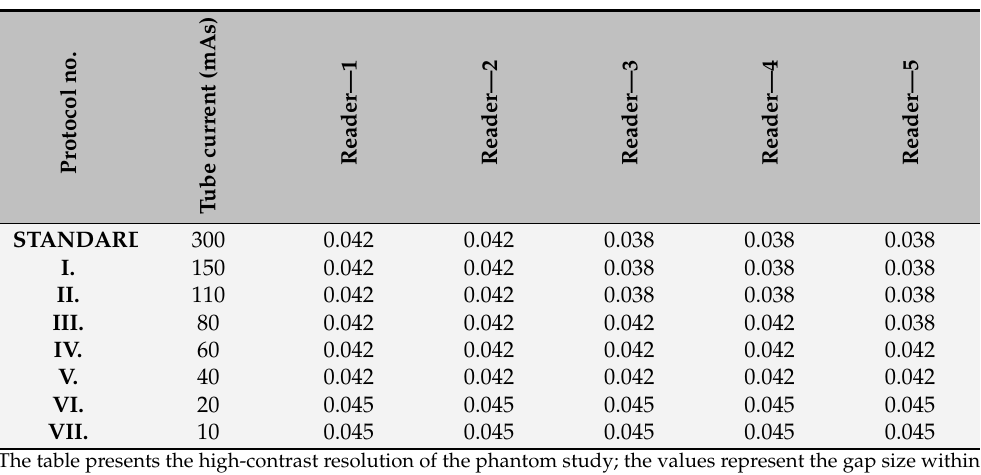
Table 4. High-contrast resolution in a corresponding phantom study; the table presents the high- contrast resolution of the phantom study; the values represent the gap size within two lines; the gap sizes were 0.045 mm, 0.042 mm, and 0.038 mm for a resolution of 11 lp/cm, 12 lp/cm, and 13 lp/cm, respectively.